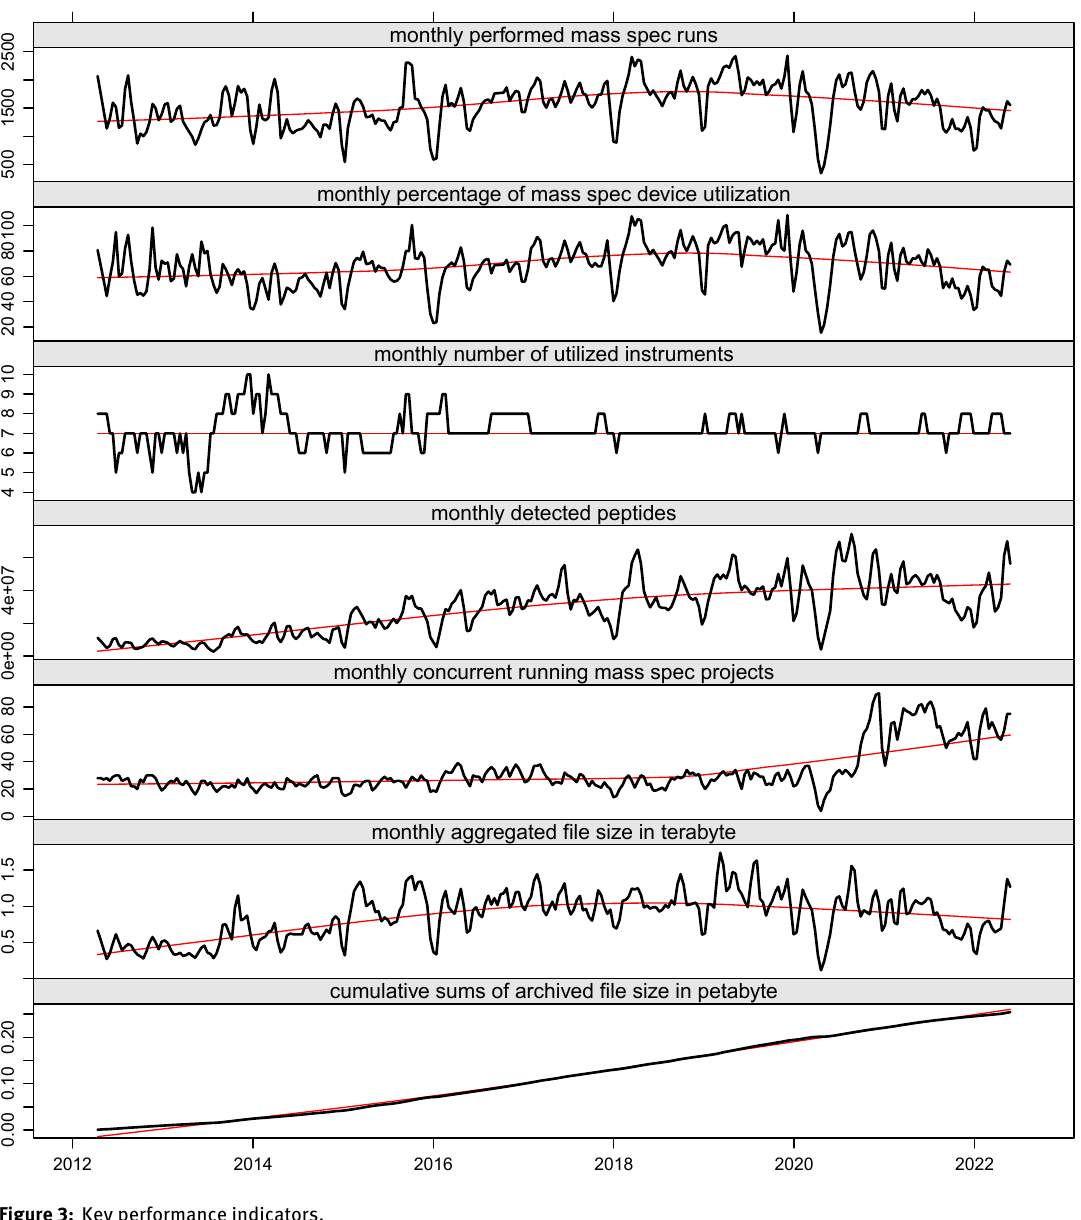
Figure 3: Key performance